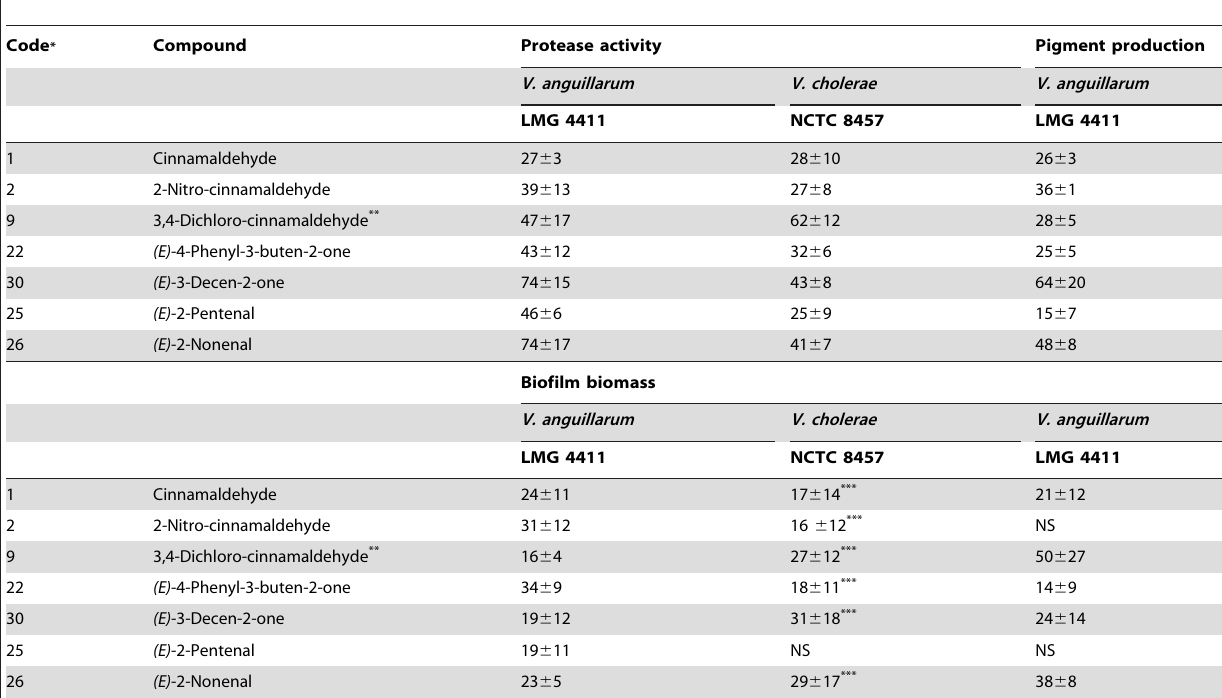
Table 3. Effect of the cinnamaldehyde analogs (100 m M) on different QS-regulated phenotypes.